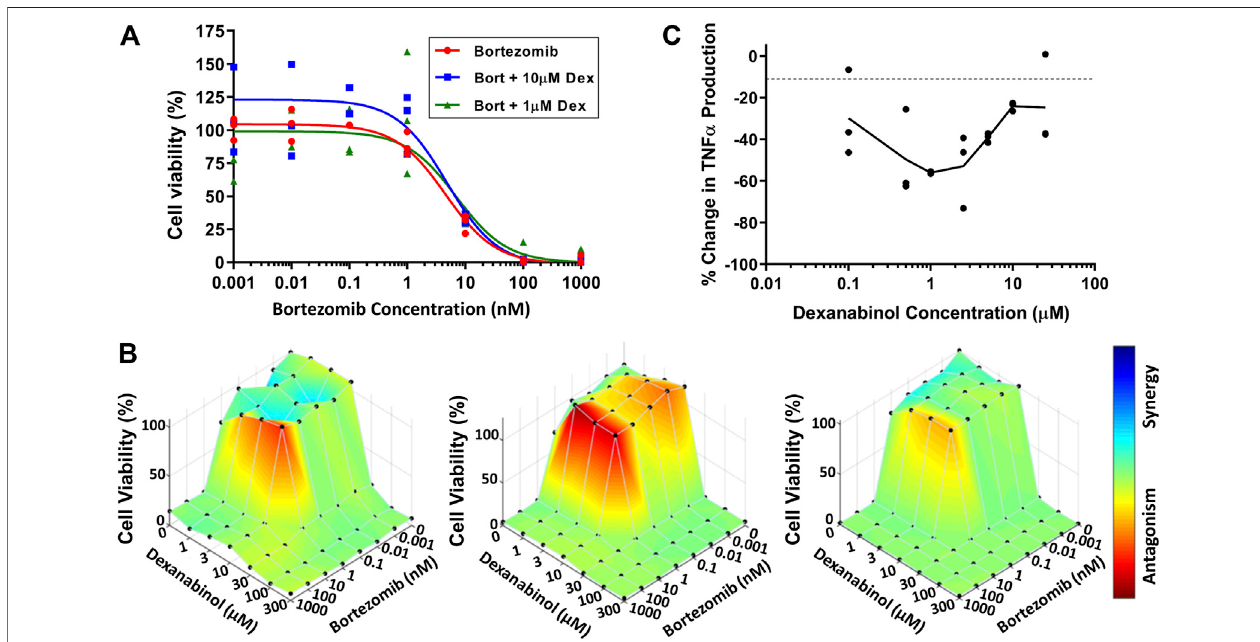
FIGURE2| Assessmentof invitro cytotoxicityofbortezomibanddexanabinol.CellviabilitywasmeasuredusingWST-1. (A) CytotoxicityofSH-SY5Ycellsexposed to various concentrations of bortezomib in the absence (red) or presence of 1 μ M (green) and 10 μ M (blue) dexanabinol. (B) Cytotoxicity of U266 multiple myeloma cells exposed to a range of bortezomib and dexanabinol concentrations for (left) 24, (middle) 48, and (right) 72 h. Antagonistic, additive, and synergistic pharmacological relationships are colored in red, green, and blue. (C) Concentration-effect relationship of dexanabinol on LPS-induced TNF α production in primary rat